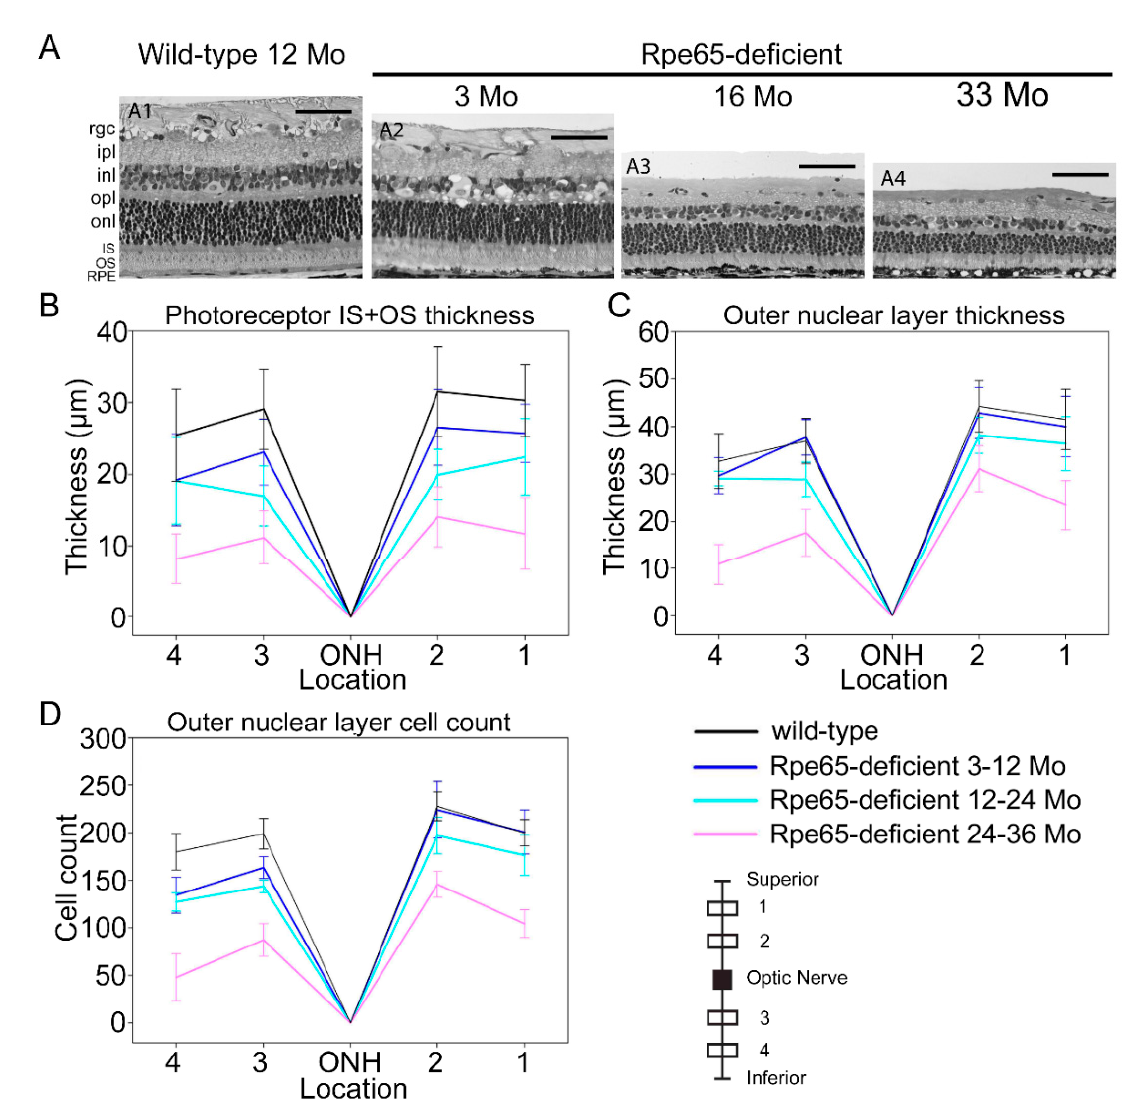
Figure 6. Changes in retinal layer thickness with age in the Rpe65-deficient dog. ( A ). Representative images at site 3 are shown in ( A1 – A4 ); a wild-type control dog 12 months of age ( A1 ); and Rpe65-deficient dogs, 3 months of age ( A2 ), 16 months of age ( A3 ), and 33 months of age ( A4 ). (Scale bars = 50 µ m.) ( B ). Changes in combined inner/outer segment layer thickness with age. ( C ). Changes in outer nuclear layer thickness with age. ( D ). Changes in outer nuclear layer cell counts with age. Measurements were performed at 4 sites, 1/3 and 2/3 between the optic nerve and ora ciliaris retinae both superior and inferior to the optic nerve (see inset schematic). Dogs are grouped as follows: wild-type control dogs 3–36 months, n = 11 eyes; Rpe65-deficient dogs 3–12 months, n = 7 eyes; Rpe65-deficient dogs 12–24 months, n = 5 eyes; and Rpe65-deficient dogs 24–36 months, n = 5 eyes.